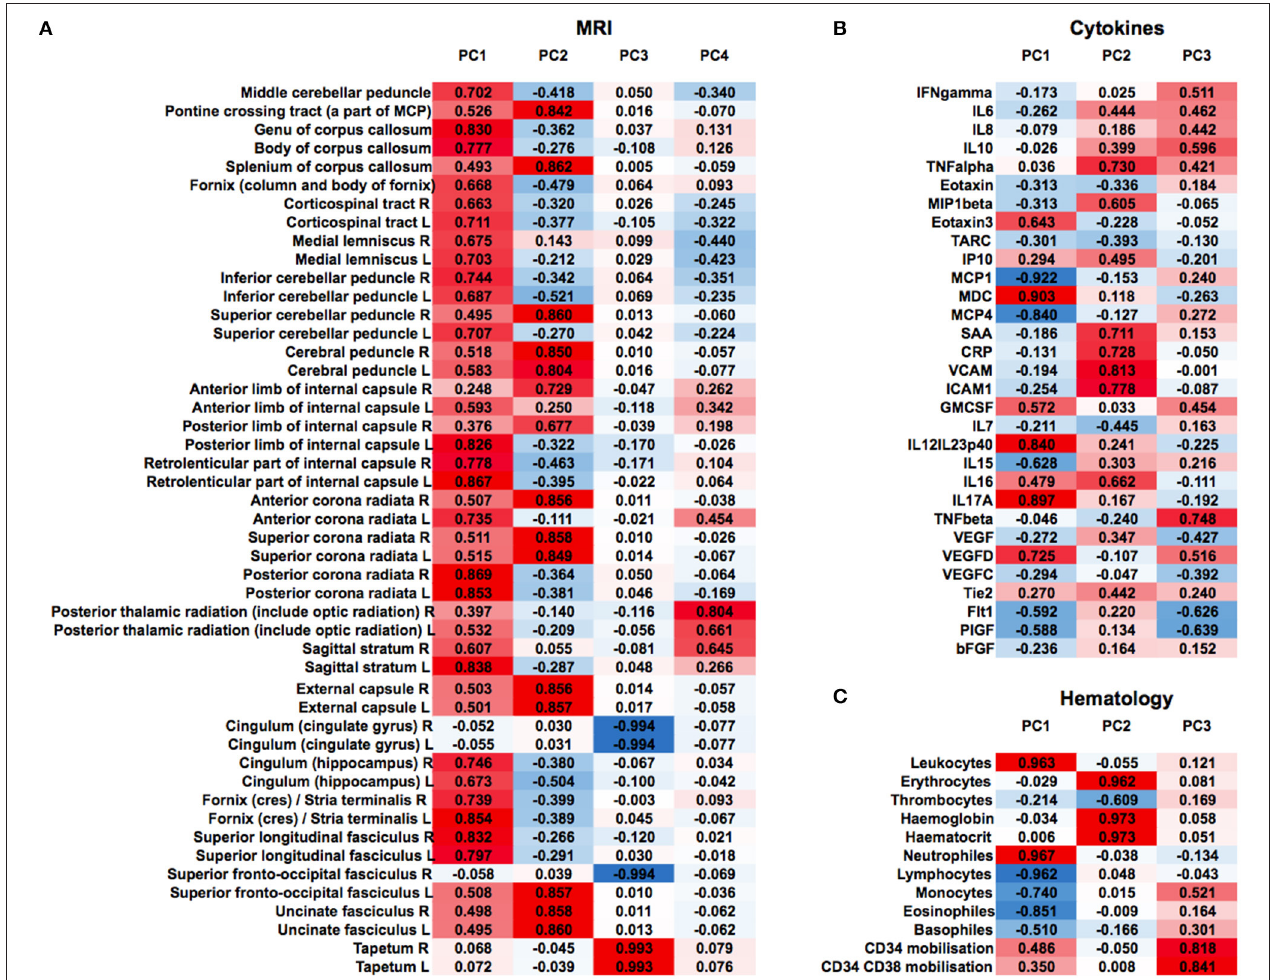
FIGURE 6 | Non-selected PCA at 12 months of filgrastim treatment. Unselected non-linear principal component analyses (PCA) of neuroimaging data [ (A) , first heat plot: fractional anisotropy (FA) in cerebral MRI DTI], cytokines and growth factors [ (B) , second heat plot], and hematology parameters [ (C) , third heat plot] at 12 months of filgrastim treatment. For single items (e.g., specific cytokine), the loading is given in absolute numbers and used for ranking; red color indicates positive magnitude of loading, blue negative magnitude of